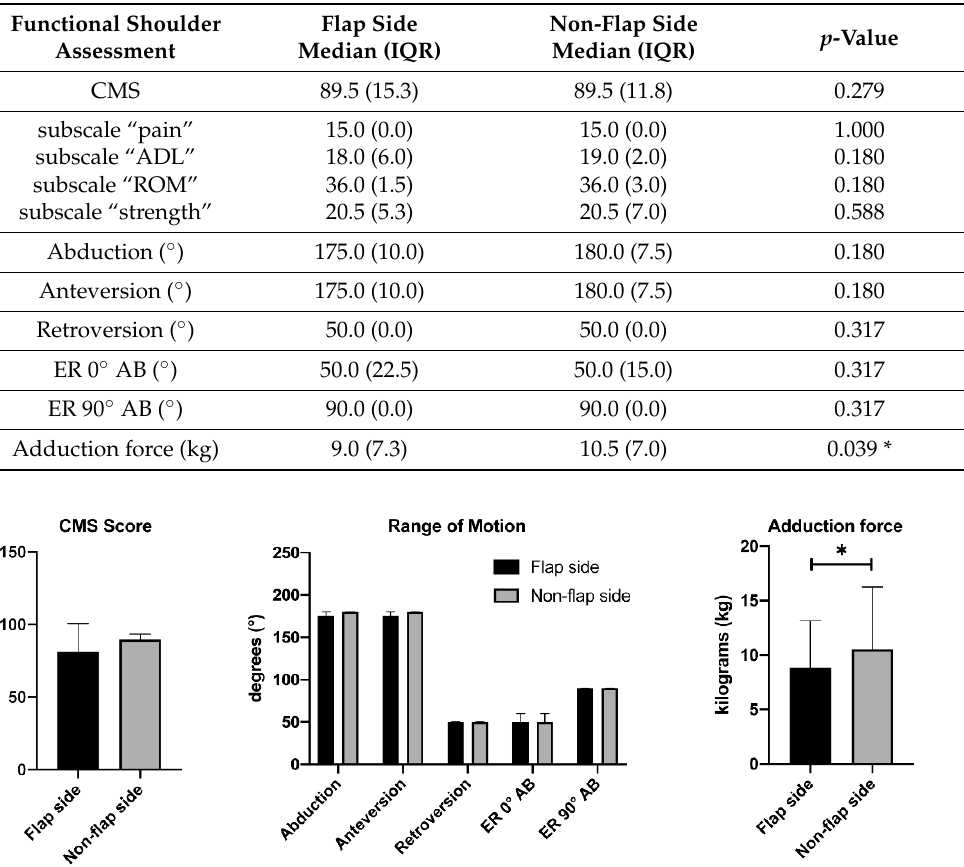
Figure 2. Constant Murley Score (CMS), median range of motion (ROM) in degrees (°) and median adduction force in kilograms (kg). Results are shown as median (IQR). A statistically significant difference was found in adduction force, p = 0.039 *.